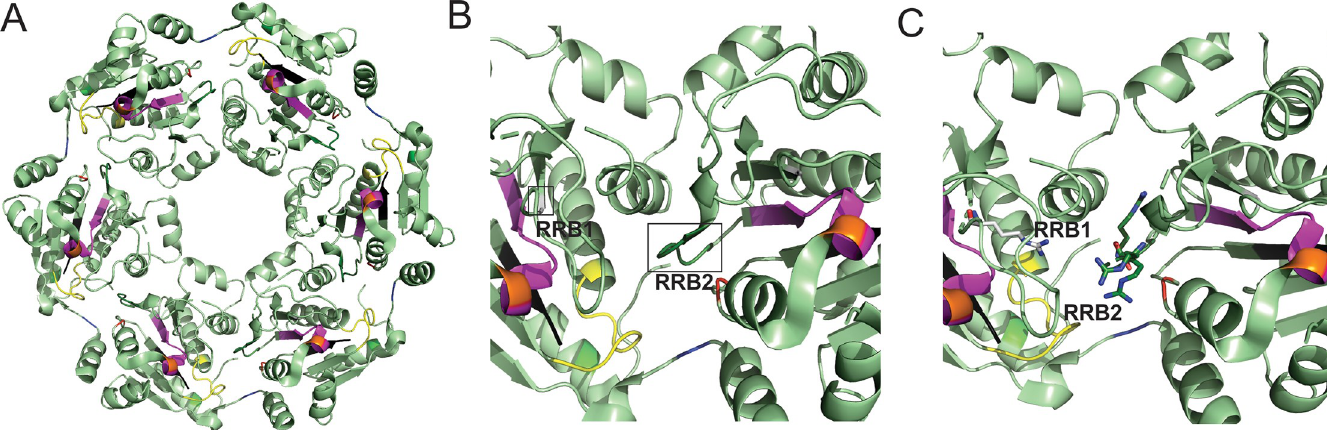
Fig 6. Hexameric structure and active site of the PhoH RNA helicase. Hexameric structure of the PhoH domain of PhoH2 (A) showing the central pore and position of conserved motifs: Q motif (green), Walker A (yellow), RNA Recognition and Binding 1 (RRB1) (light grey), RRB2 (dark green), Walker B (magenta), Sensor I (orange), Second Region of Homology (red), Motif III (black) and Sensor II (blue) [12]. (B) Magnified view of the PhoH active site that forms between two adjacent monomers. The positions of RRB1 and 2 are highlighted (boxed) and located on loops. (C) Magnified view of PhoH2 active site showing the position of highly conserved arginine residues (shown as sticks) critical for RNA recognition and binding. Images were made in PyMol V2X using PDB 3B85.